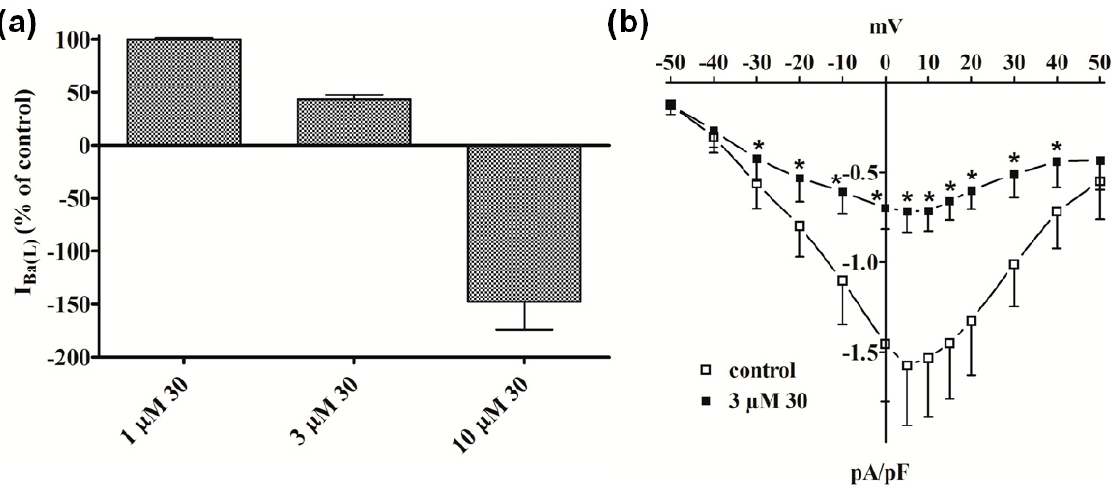
Figure 3. Effect of compound 30 on I Ba(L) in single tail artery